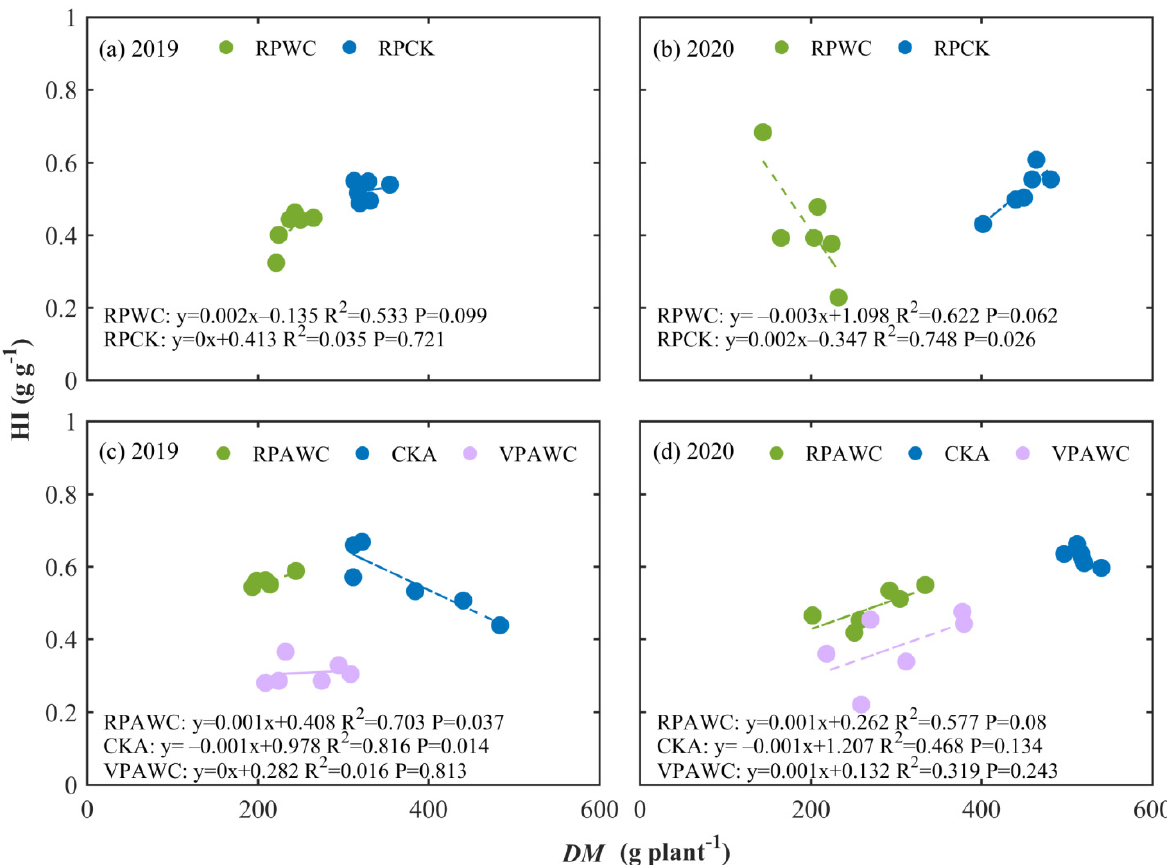
Figure 5. Relationships between HI and shoot during growth ( a , b ) and at the end of growth ( c , d ) in 2019 and 2020. 2019 and